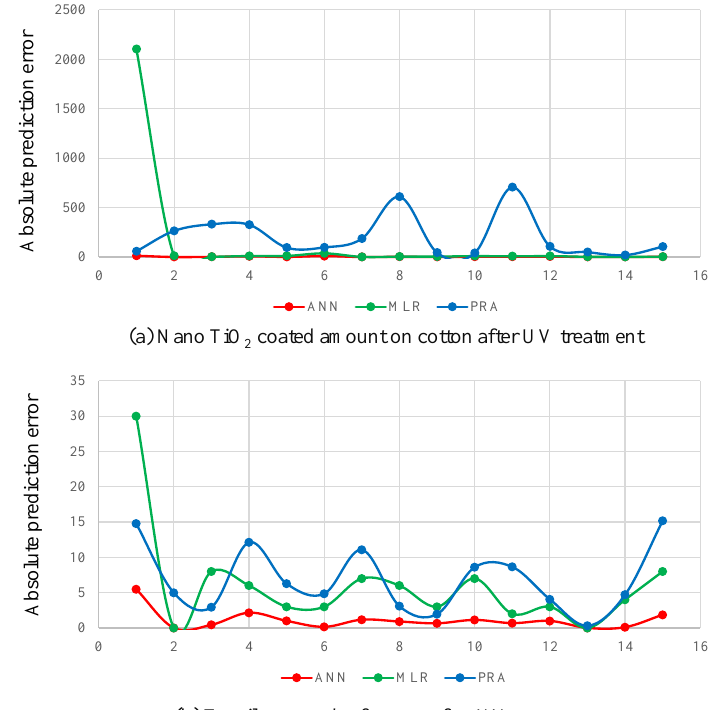
Figure 6. ( a ) Absolute prediction error ( | y − ˆ y | ) of nano TiO 2 coated amount after UV treatment under ANN, MLR and PRA. ( b ) Absolute prediction error of tensile strength of cotton after UV treatment under ANN, MLR and PRA.